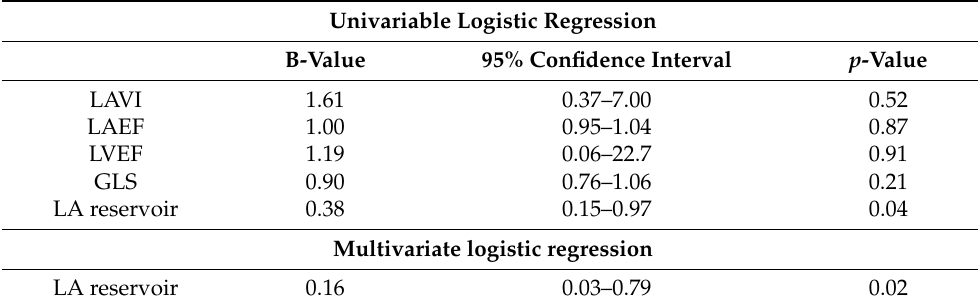
Table 4. The association of variables with the type of cardiac amyloidosis using logistic regression